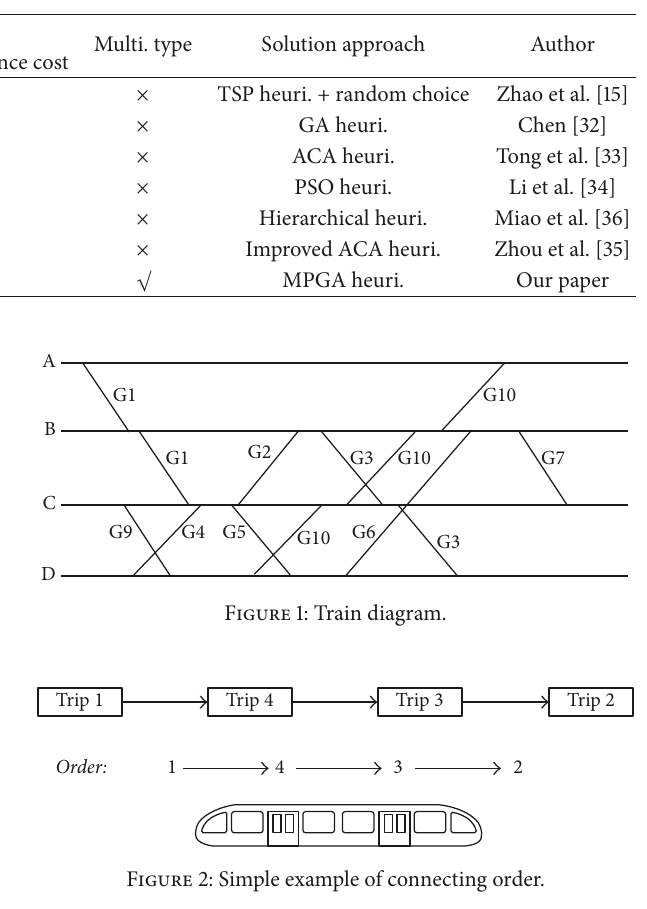
Table 1: Comparison of different papers.